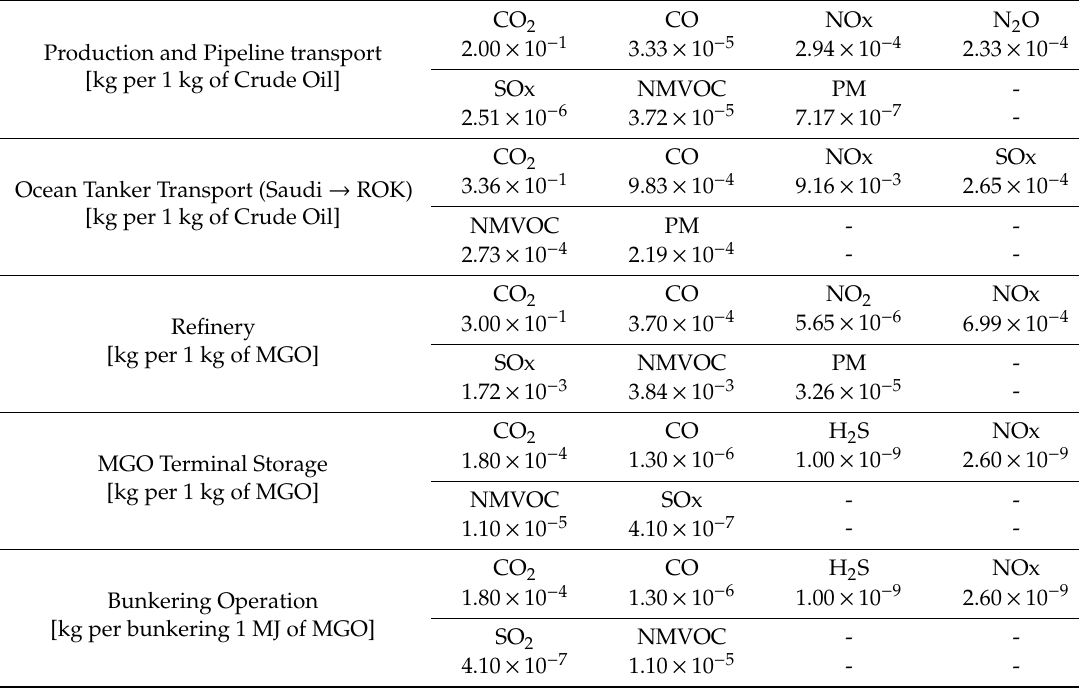
Table A2. Emission factors of MGO in the Well-to-Tank